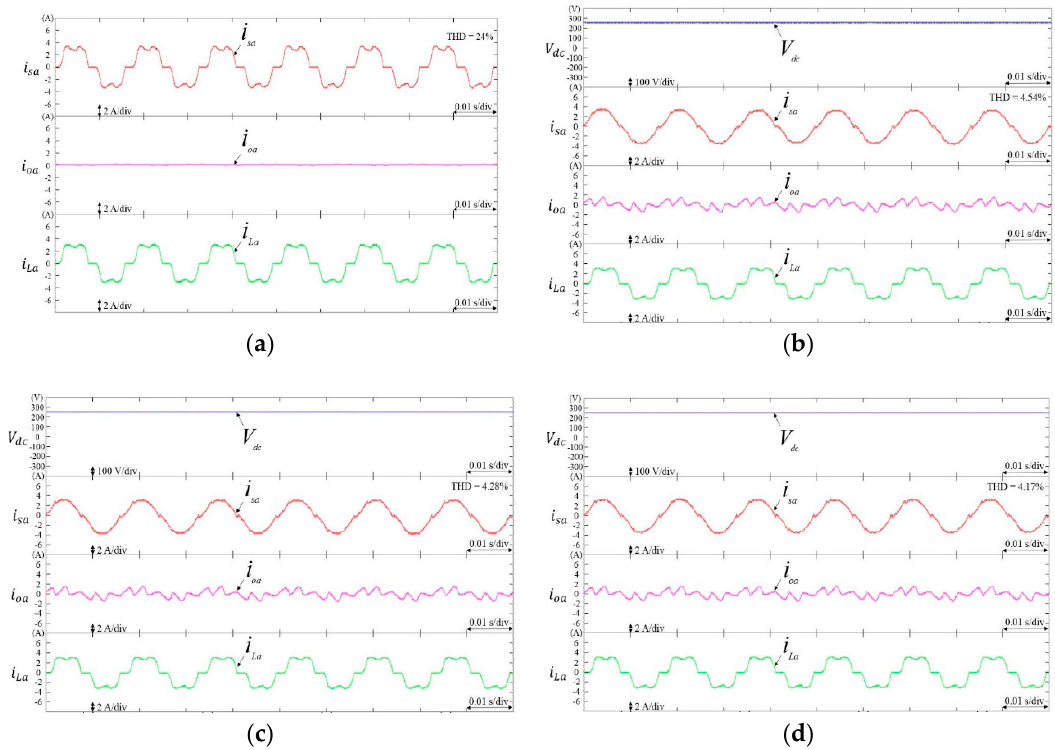
Figure 5. Experimental results at nonlinear load 3: ( a ) Without using DSTATCOM; ( b ) Using PI controlled DSTATCOM; ( c ) Using CFNN controlled DSTATCOM; ( d ) Using proposed CFNN-AMF controlled DSTATCOM.